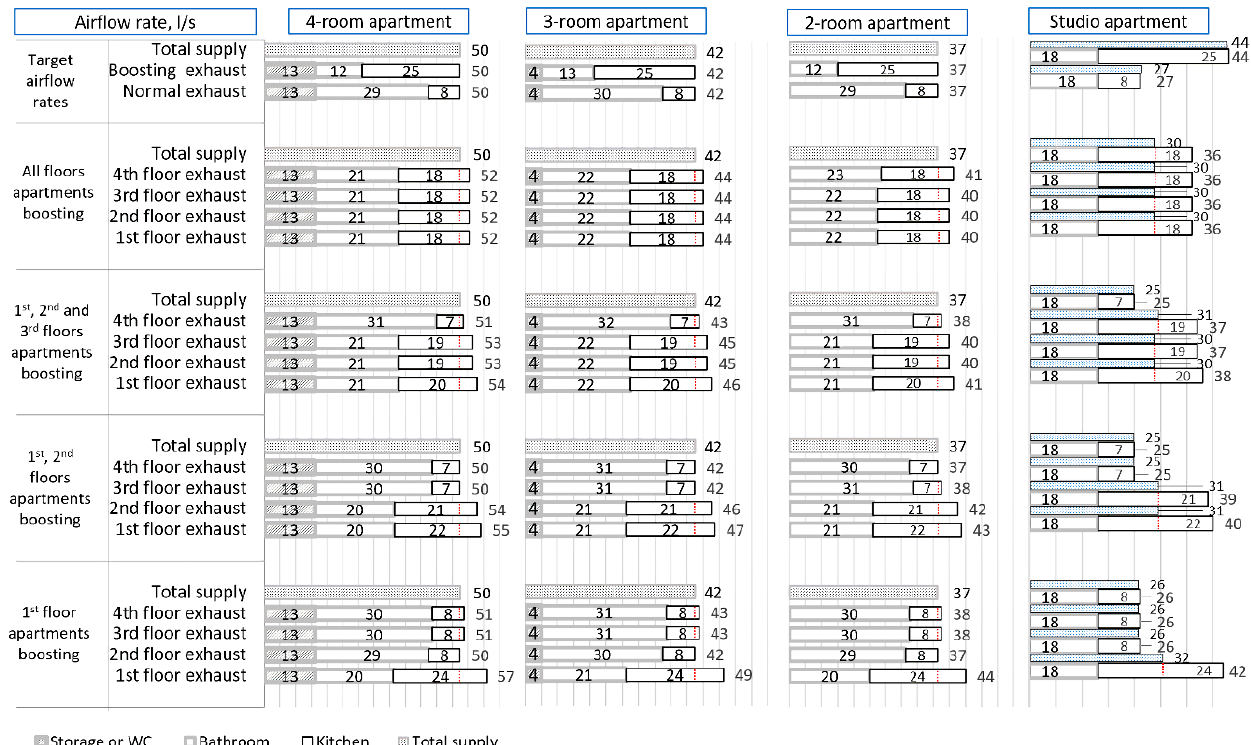
Figure 4. Airflow rates of the different sizes of apartments when a different number of apartments are boosting.